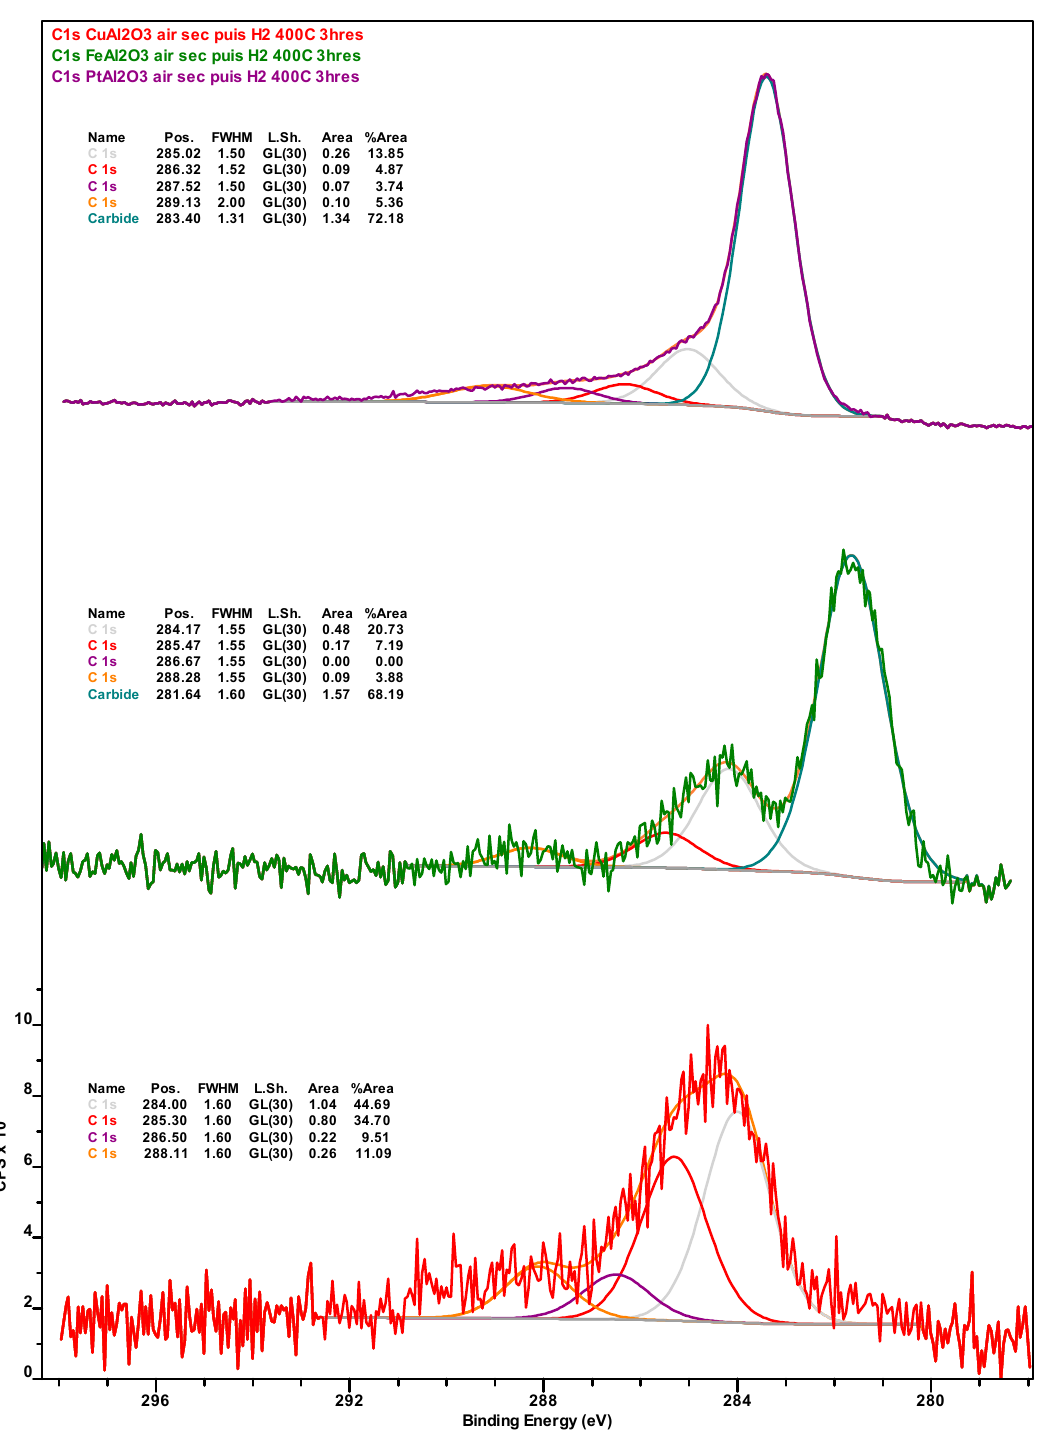
Figure A6. Carbon 1s X-ray photoelectron spectra of the spent Ni-Cu (red spectrum), Ni-Fe (green spectrum), and Ni-Pt (purple spectrum) catalysts recovered from the deoxygenation experiments after calcination in air at 450 °C for 5 h and reduction under H 2 at 400 °C for 3 h.